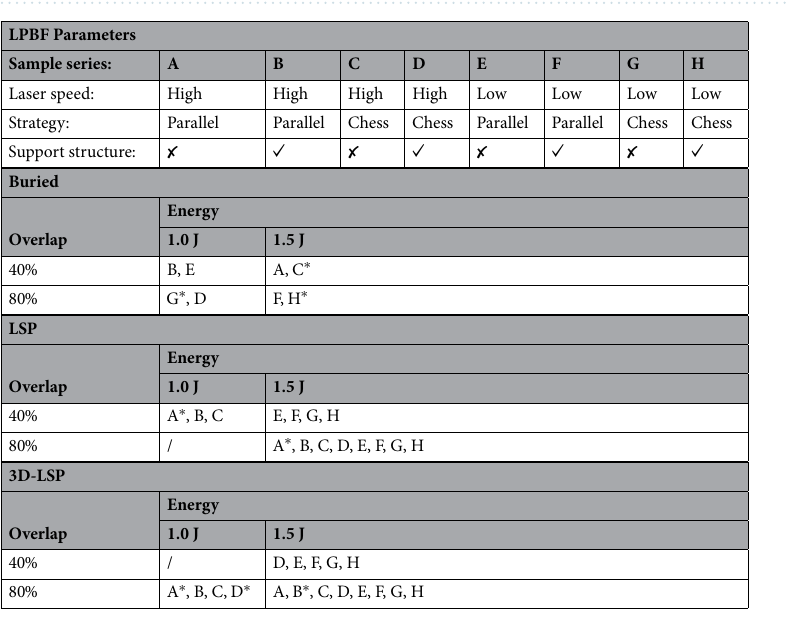
Figure 2. Diagram sketch of different production parameters used to build the samples and a picture of one specimen, where the chess LPBF scanning pattern is visible and the dark area corresponds to the part of the sample that has been treated with LSP.